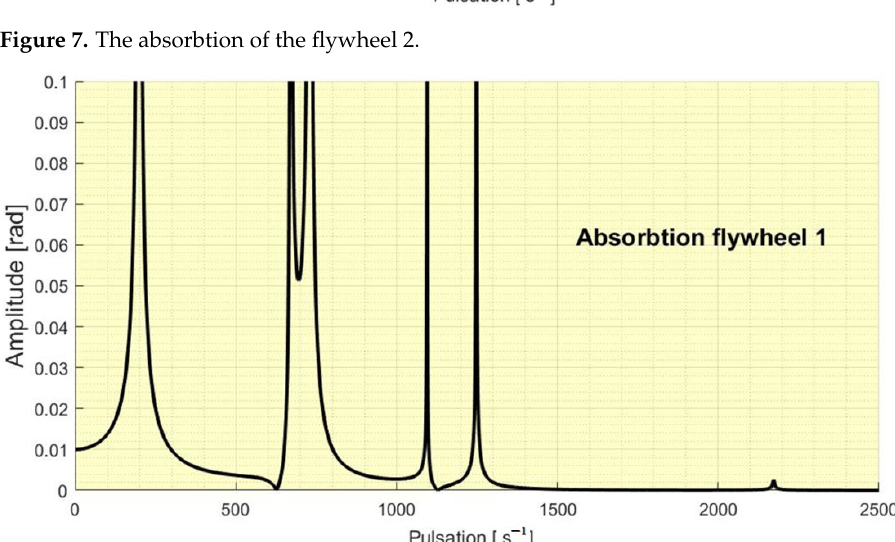
Figure 8. The absorbtion of the flywheel 1. The eigenpulsations of the system are presented in the Table 3. In Figure 9 are presented the amplitude of the all six flywheel overlapped.